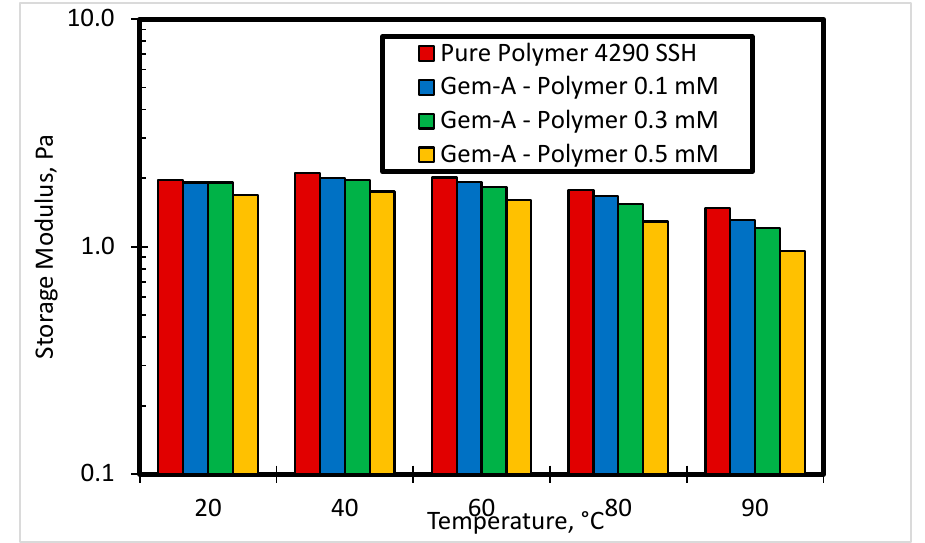
Figure 13. Effect of temperature on storage modulus at different concentrations of Gem-A in SP system at angular frequency 10 rad/s.